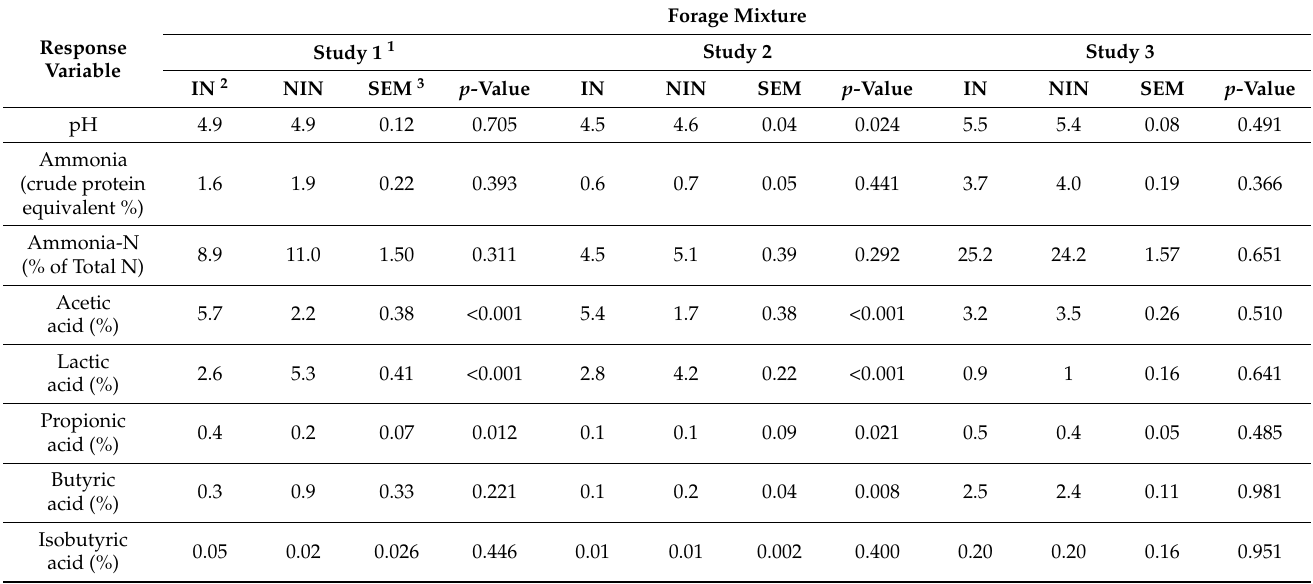
Table 4. Fermentation parameters of forage mixtures ensiled under two inoculant